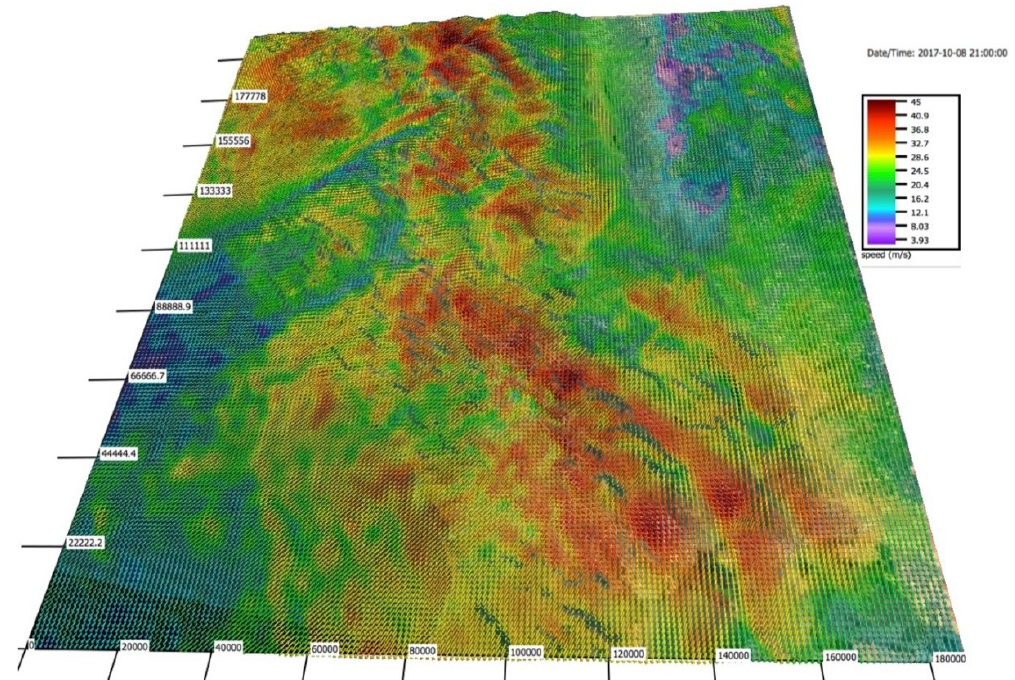
Figure 8. Simulated near-surface winds (8.5 m above ground level) on 8 October at 9:00 p.m. over the region shown in Figure 7. Wind speed arrows point downstream and are colored according to the color bar at right (in m/s). Imagery was produced with VAPOR (www.vapor.ucar.edu), a product of the Computational Information Systems Laboratory at the National Center for Atmospheric Research. In motion, as shown in Video S1, the field of arrows conveys changes in direction and strength of the Diablo winds.